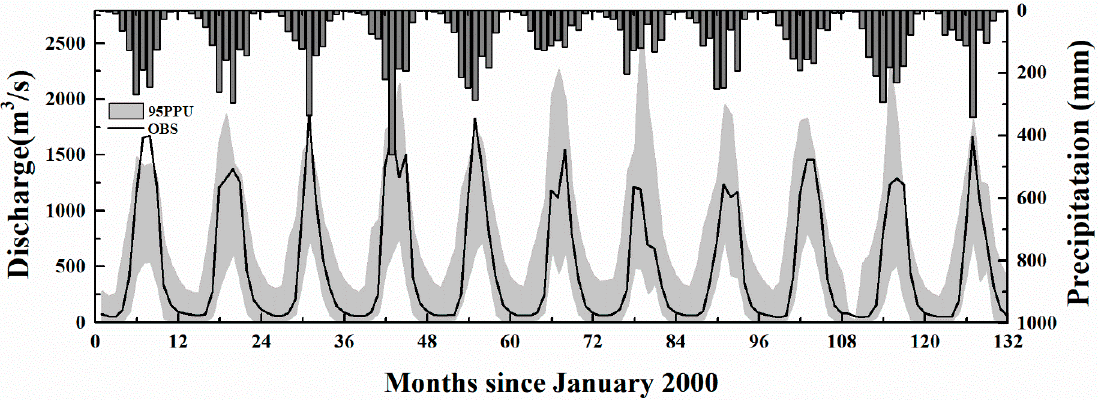
Figure 4. Observed and simulated total runoff and precipitation during calibration and validation.